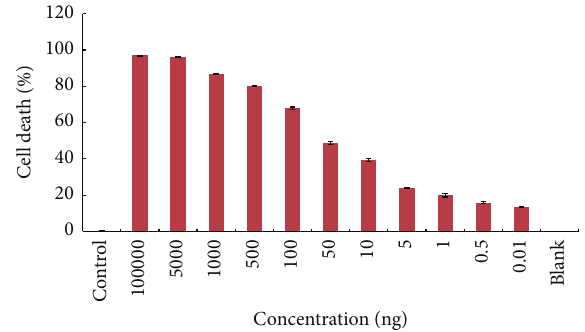
Figure 4: Cytotoxic effect of liver oil using MTT assay. Data expressed as a percentage of cell death. Value represents the mean ±